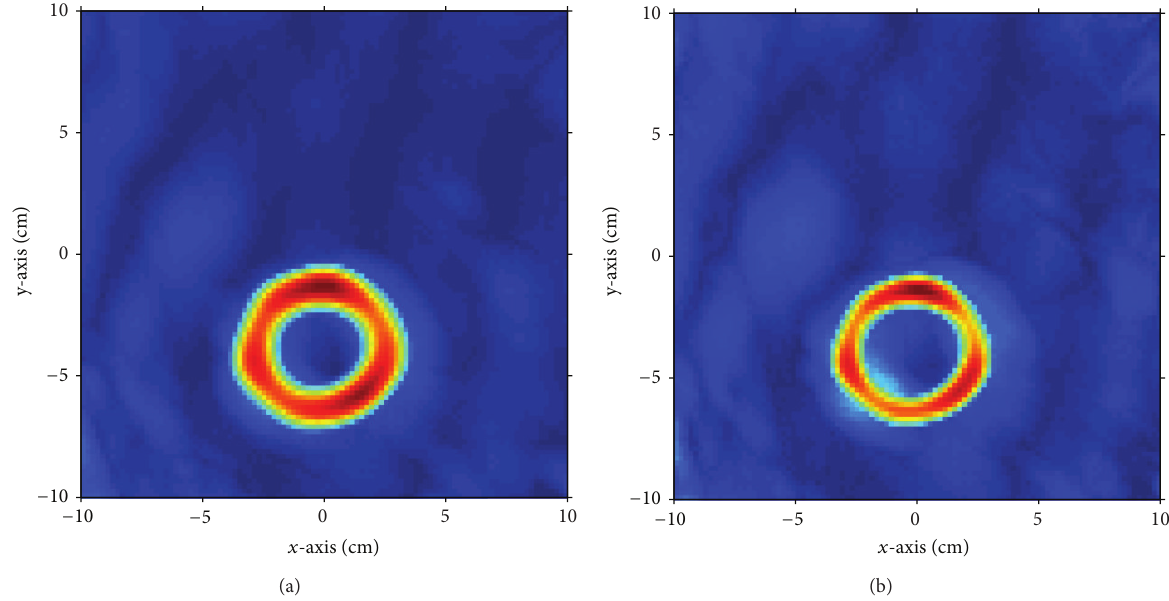
Figure 4: Reconstruction of PVC pipe from measurements, using ART with the enforcement of the physical bounds. The figure shows the reconstruction differences when using 𝜇 = 0.8 (a) and 𝜇 = 1.4 (b).